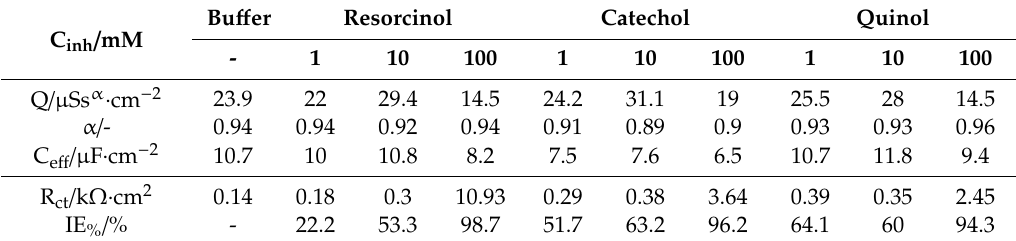
Table 1. Electric parameters of the studied systems obtained from EIS results fitted with R(QR) EEC. Bu ff C inh / mM